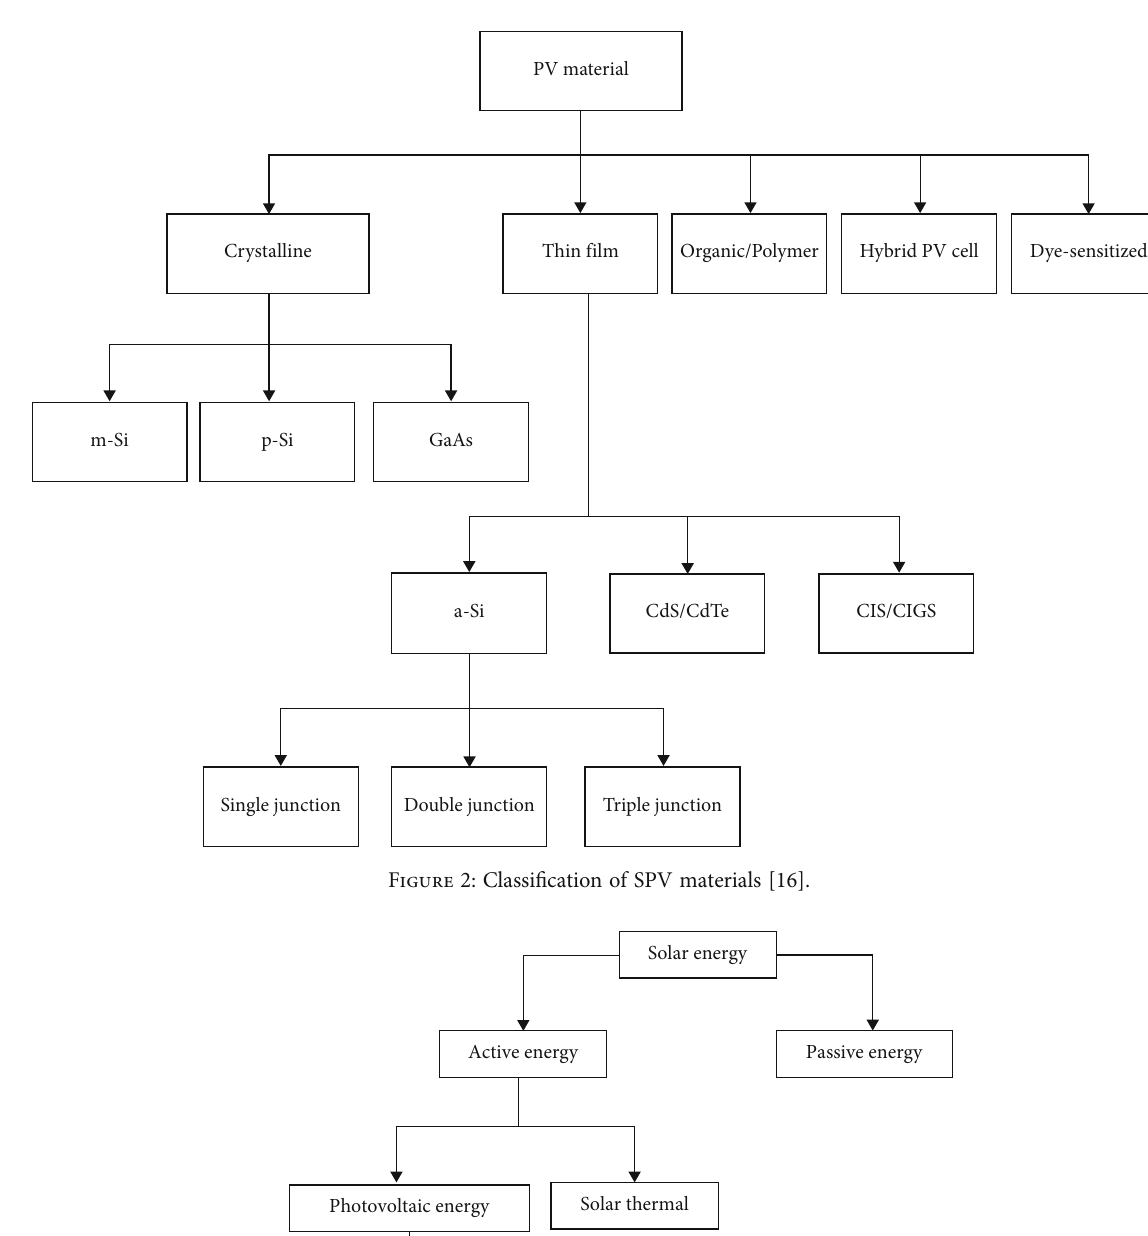
Figure 3: Classi fi cation of SPV materials based on SPV applications